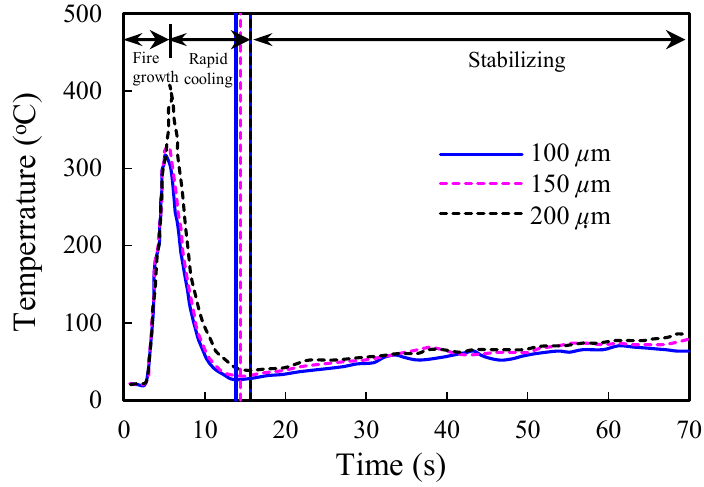
Figure 13. Time histories of temperatures for various water mist droplet sizes [29].